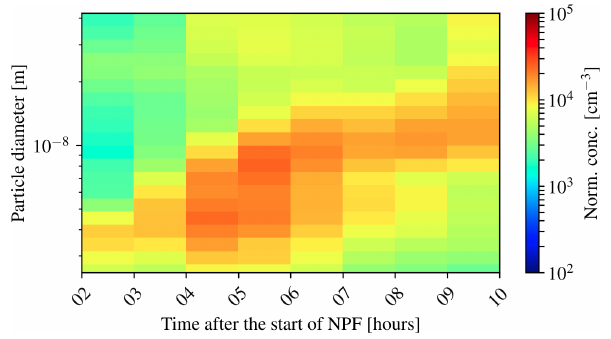
Figure 12. The particle number-size distribution above was con- structed using the SMEAR II station’s NAIS data by taking the roll-induced NPF observations (29d and 46 different roll-induced NPF events) and distributing them along the time axis according to their geometric mean diameter while assuming a growth rate of 1.8nmh − 1 (median of the obtained GRs) and start of the NPF at t =